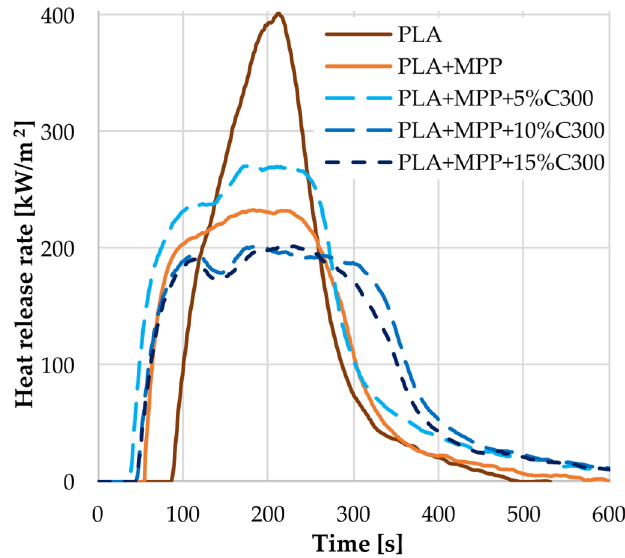
Figure 2. Heat release rate curves of the samples with different neat cellulose content. Table 5. Average mass loss calorimetry results of the composite samples with different neat cellu- lose content.